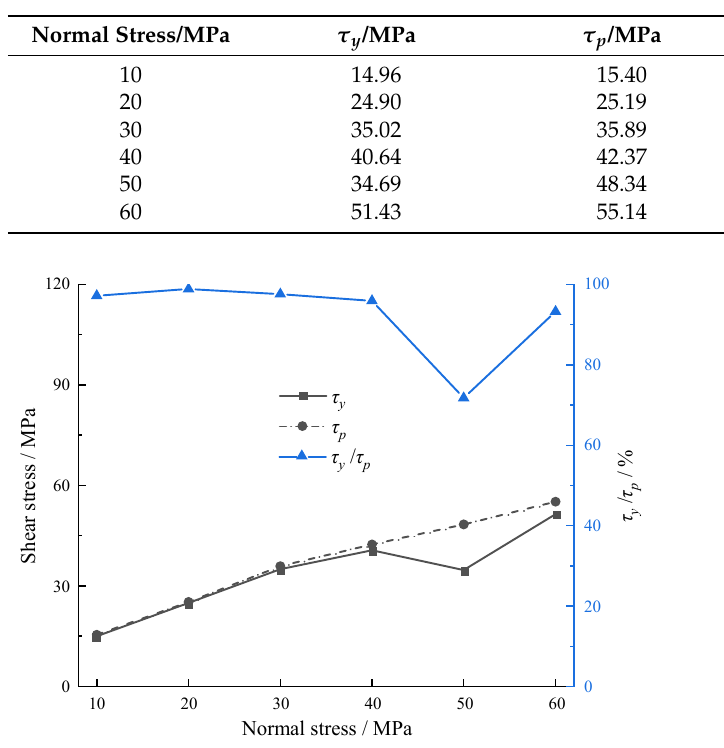
Figure 14. Yield stresses under different normal stresses (Note: τ p data are from Zhou et al. [78]).